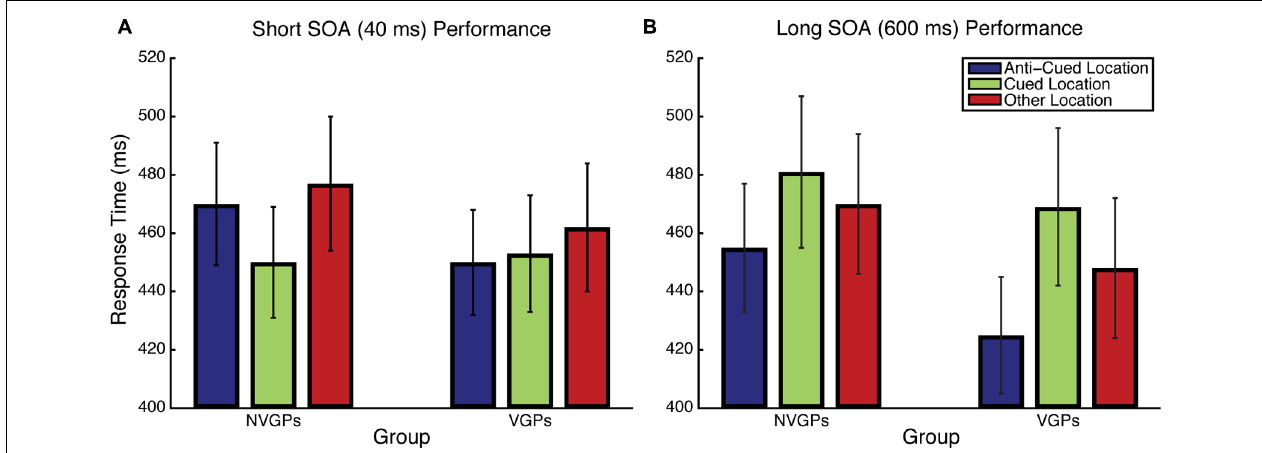
FIGURE 2 | Response time results for Experiment 1 for the Short SOA (A) and Long SOA (B) conditions. Error bars represent the standard error of the mean.